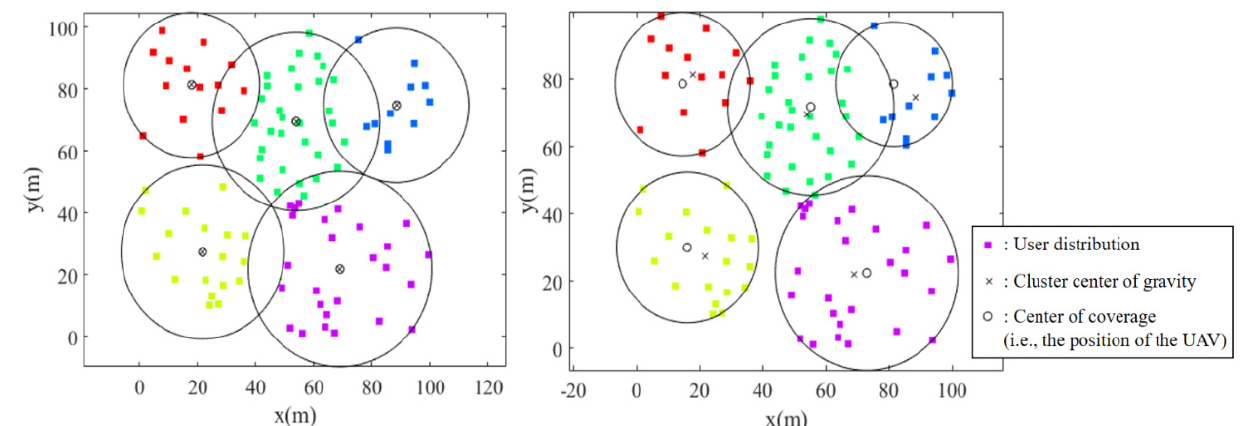
Figure 3. Coverage circle without (left) or with (right) adaptation to the smallest-circle problem.